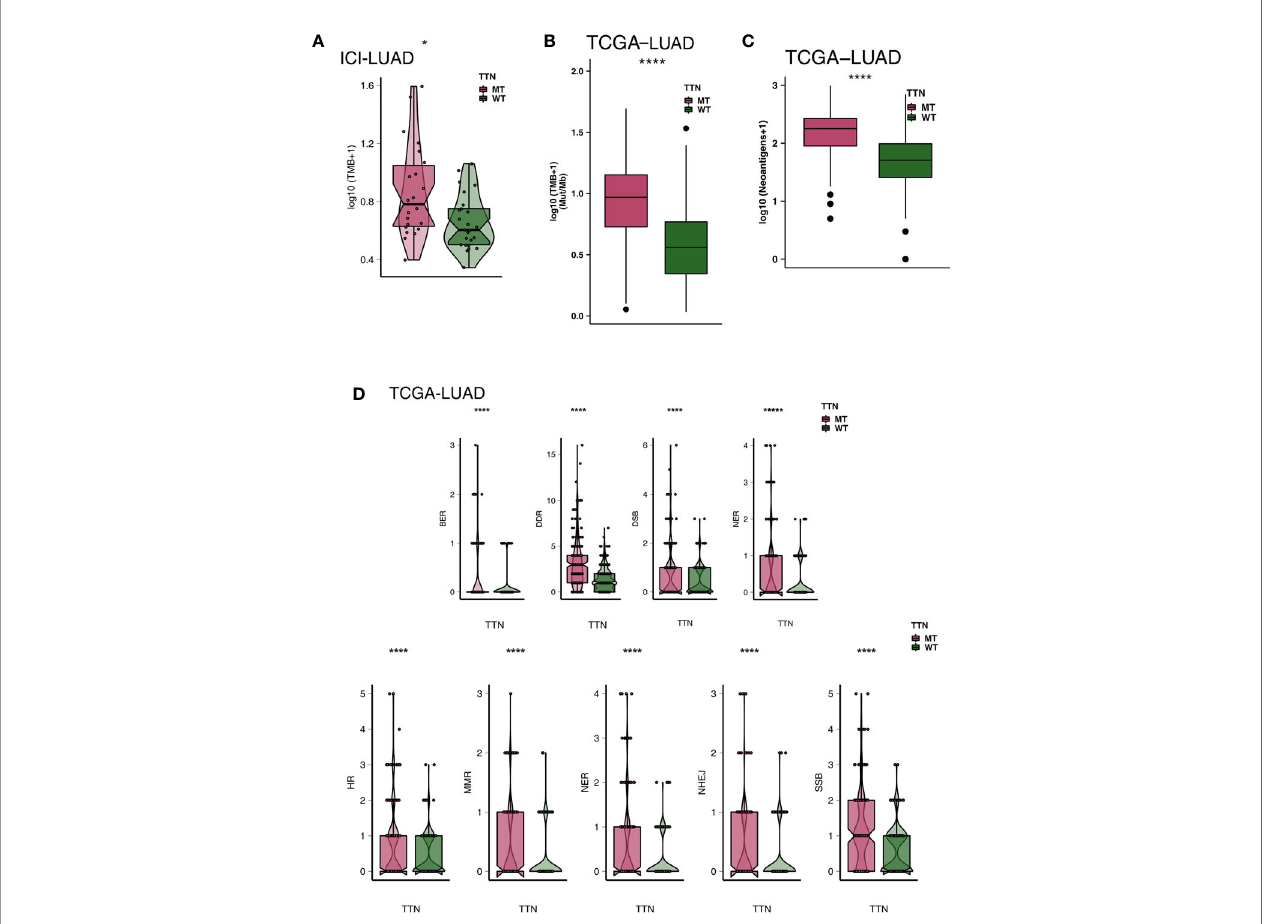
FIGURE 4 | An association of TTN status and immunogenicity in the LUAD patients. Comparison of TMB between TTN-MT and TTN-WT tumors in the ICI-cohort (A) and the TCGA-LUAD cohort (B) . (C) Comparison of NAL between TTN-MT and TTN-WT tumors in the TCGA-LUAD cohort. (D) Comparison of mutation counts of DDR signaling pathways between TTN-MT and TTN-WT tumors in the TCGA-LUAD cohort. *P < 0.05; ****P <